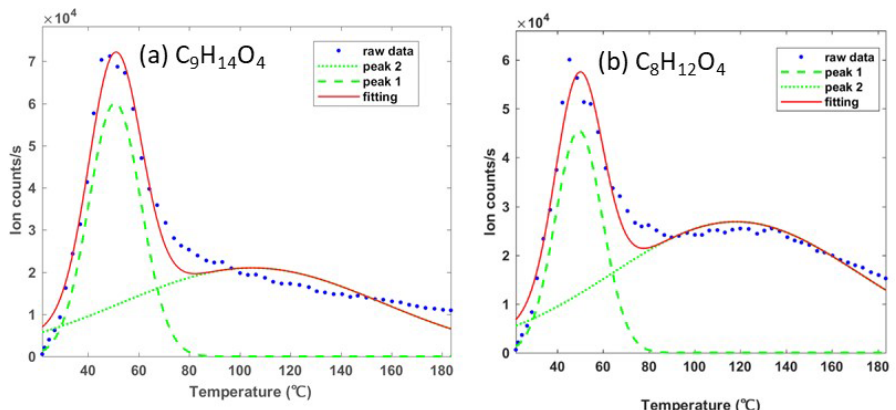
Figure 1. Two examples of an ion with more than a single desorption peak in the FIGAERO-CIMS. Here the peaks at the lower desorp- tion temperature were assigned to monomers C 9 H 14 O 4 (a) and C 8 H 12 O 4 (b) generated from α -pinene directly, with the broader higher- temperature peaks being a fragment of another ion at the same mass.